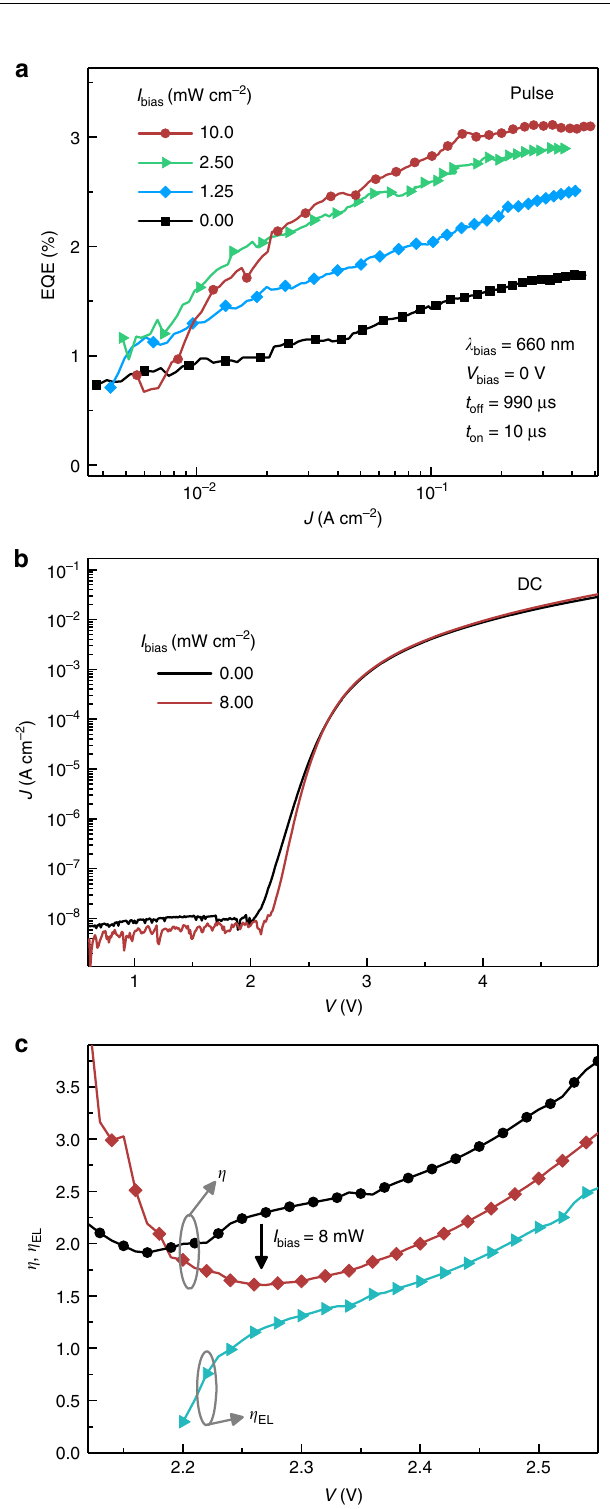
Fig. 4 Effects of background illumination. a Pulsed external quantum ef fi ciency recorded under varying levels of background illumination provided by a λ = 660 nm laser. b Under illumination, the slope of the DC current – voltage characteristic increases in the diode-like exponential region. c Ideality factor calculated for both the DC current ( η ) and electroluminescence ( η EL ) as described in the text. Background illumination causes η to decrease toward η EL , re fl ecting a reduction in